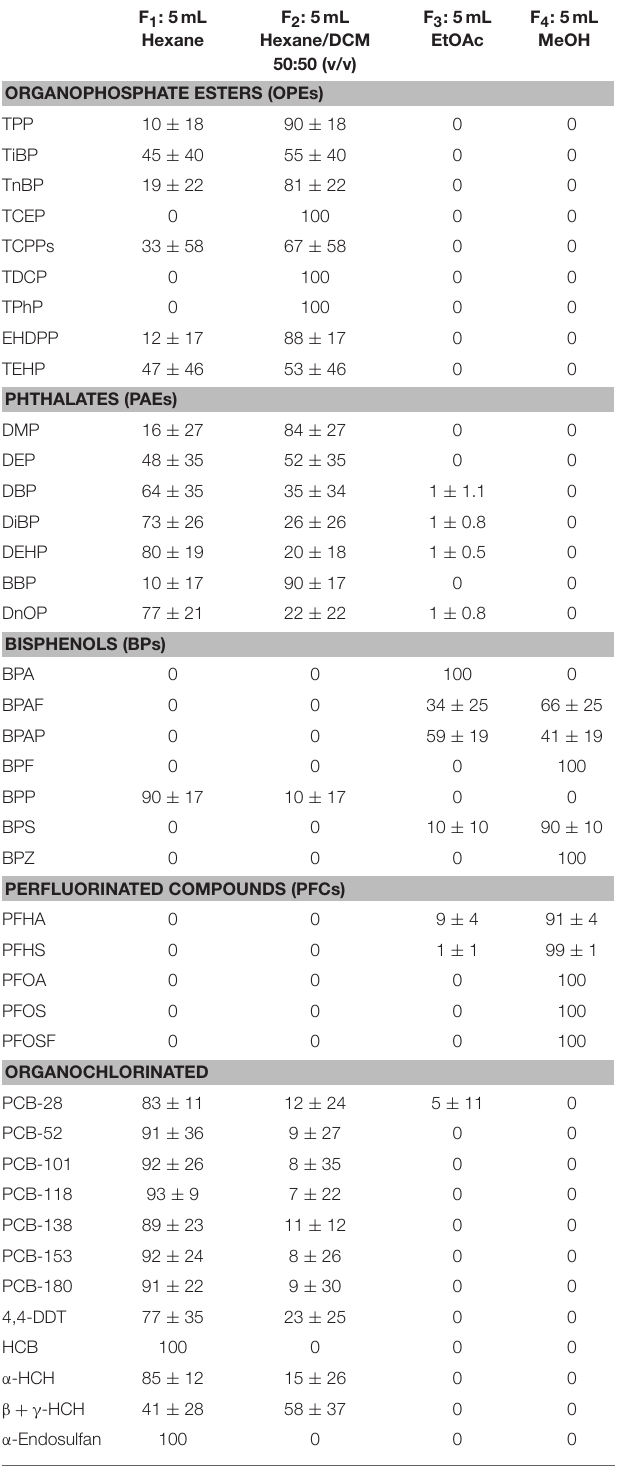
TABLE 2 | Distribution of 40 target analytes in the four consecutive elution fractions.